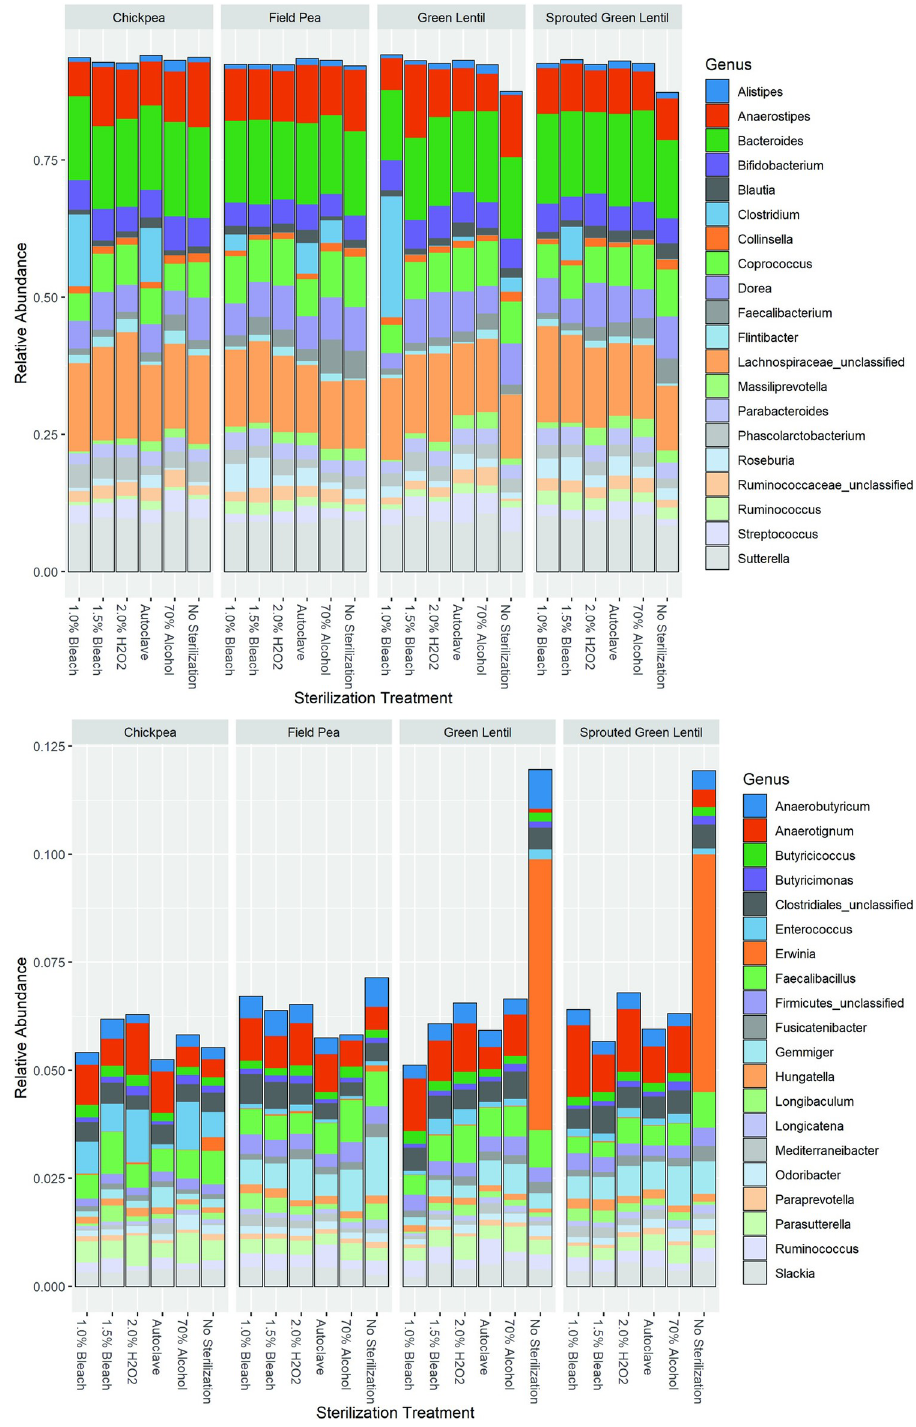
Fig 3. Relative abundance of microbes in simulated in vitro colonic fermentations run for 24 h at 37˚C with fecal addition. Each set of treatments is grouped by pulse identity. (A) Relative abundance of the top 20 genera. (B) Relative abundance of the next 20 most abundant